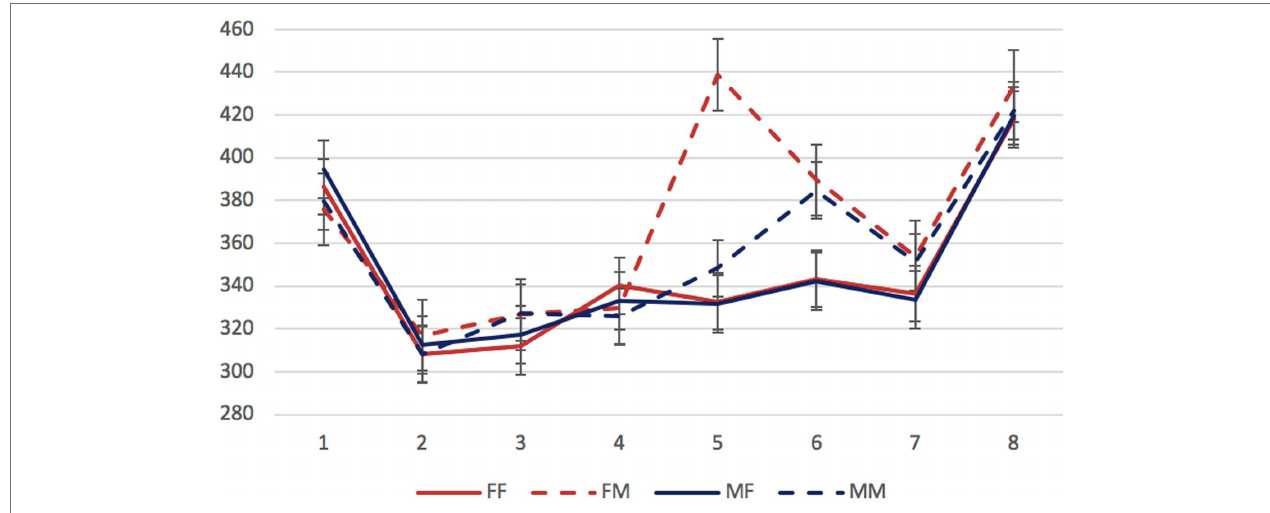
FIGURE 4 | Experiment 2, the syncretic head group: mean RTs per region (in ms) in the four experimental conditions. Regions: N 1 (head)—preposition—N 2 (dependent)—copula ( byt’ “to be”)—adjective/participle—three words modifying the predicate. Error bars represent the standard error of the condition